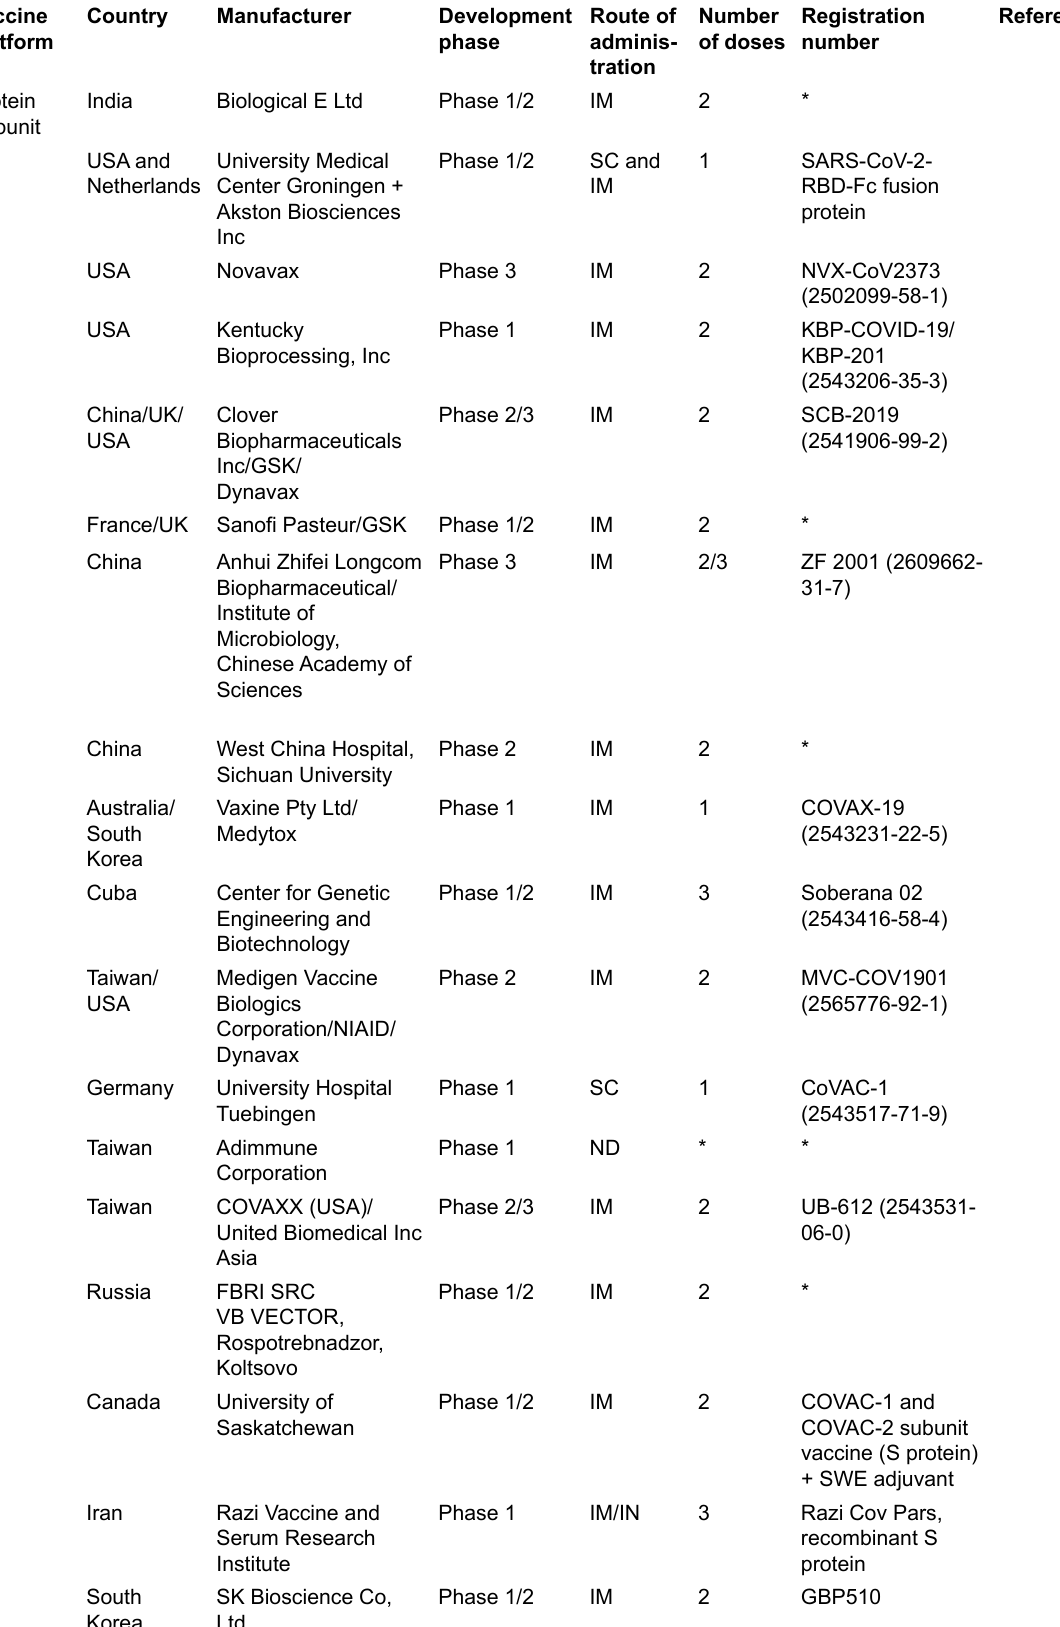
Table 2. Current development status of COVID-19 vaccine ( continued ) Sr No